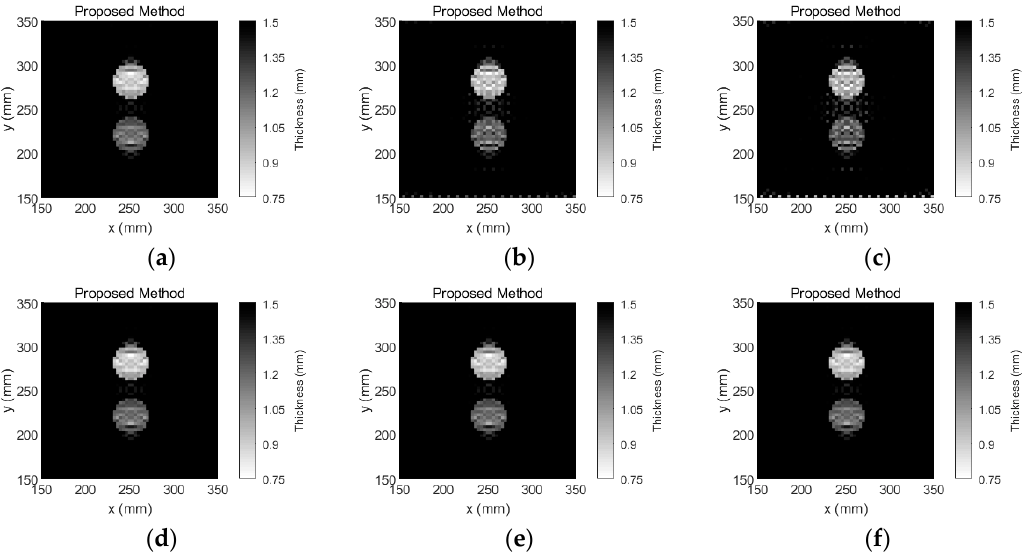
Figure 10. Tomographic reconstruction images for a 1.5-mm-thick aluminum plate with 40-mm- diameter circular flat-bottomed holes. Their thickness losses are 50% and 30% within the flaws. ( a